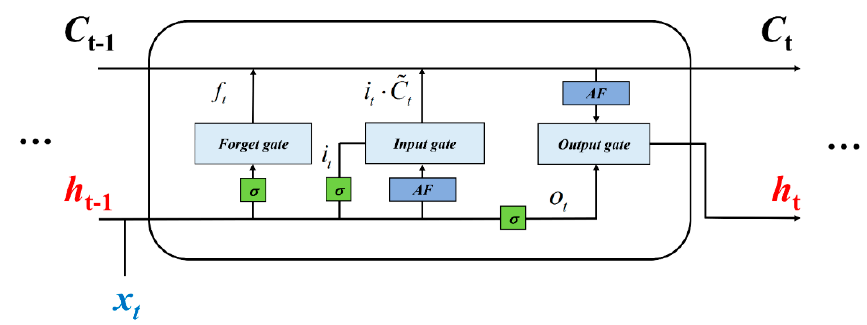
Figure 1. Illustration of the repeating network structure of Long-Short Term Memory (LSTM).